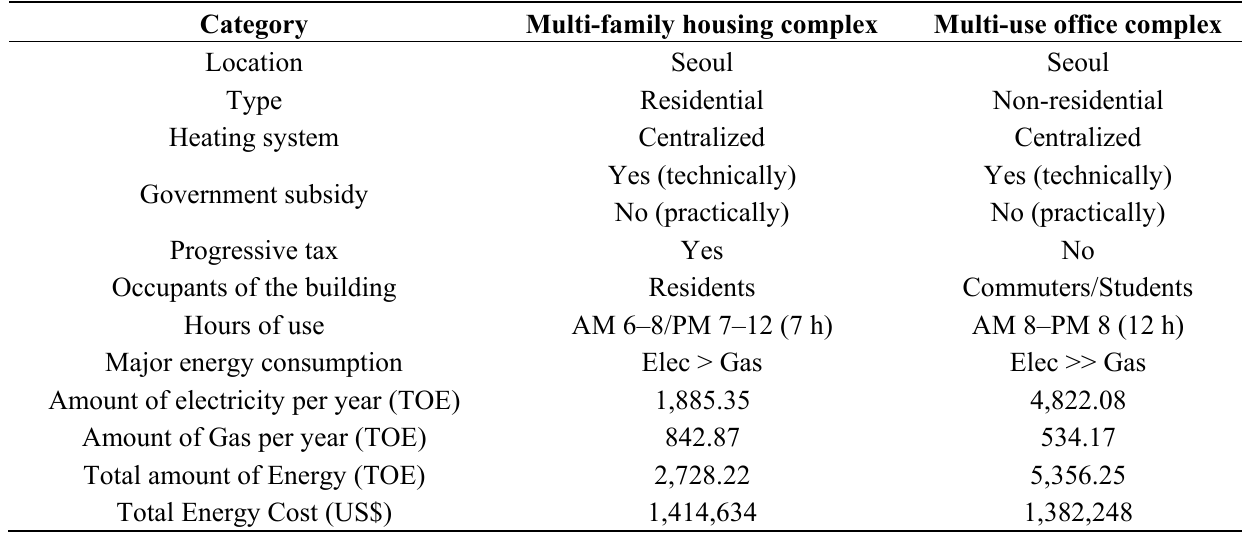
Table 1. Overview of Target